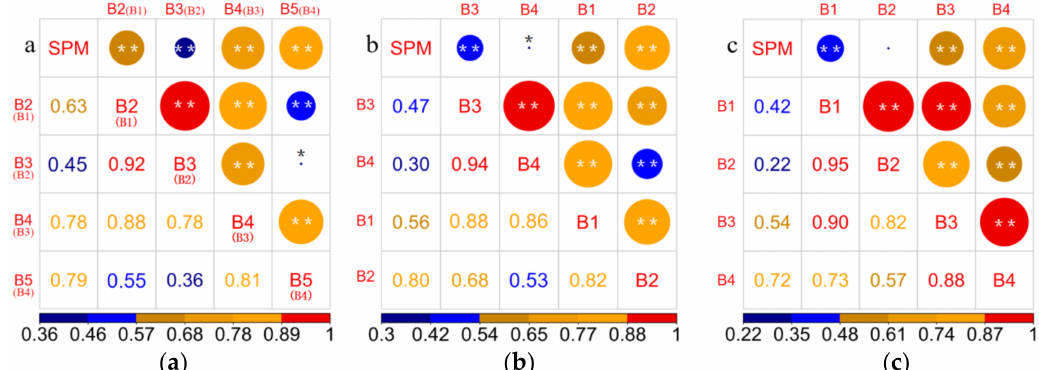
Figure 3. Correlation map of the sensitive bands of suspended particulate matter (SPM): ( a ) represents the correlation between Landsat7/8 and SPM, and the bands of Landsat-7 involved in the calculation are in brackets ( b , c ) represent the correlation of MODIS and Sentinel 2 with SPM, respectively. In addition, the color of the circle is the same as the color of the number. The symbol * represents the significance level of 0.05, and ** 0.01.